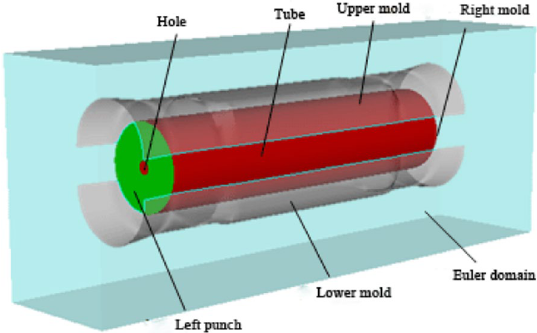
Figure 15 Geometric model based on the fluid–solid coupling method